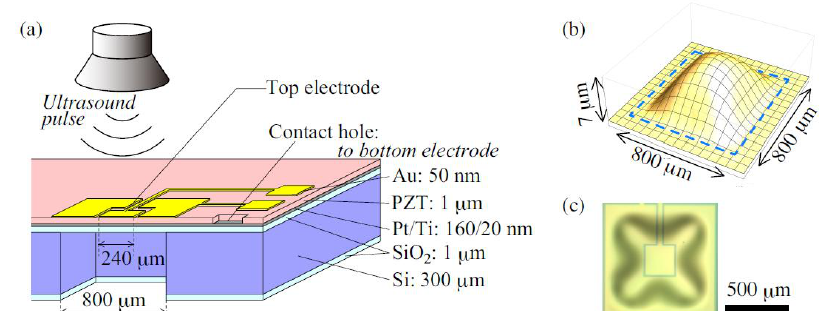
Figure 1. The sensor structure with a buckled diaphragm. ( a ) A schematic illustration of the sensor structure; ( b ) a profile of a buckled diaphragm; and ( c ) its photograph.